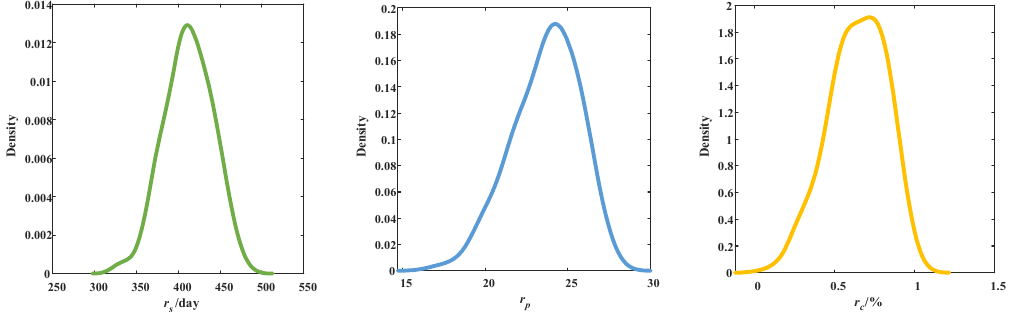
Figure 6. Nuclear density estimation results of r s , r p and r c .